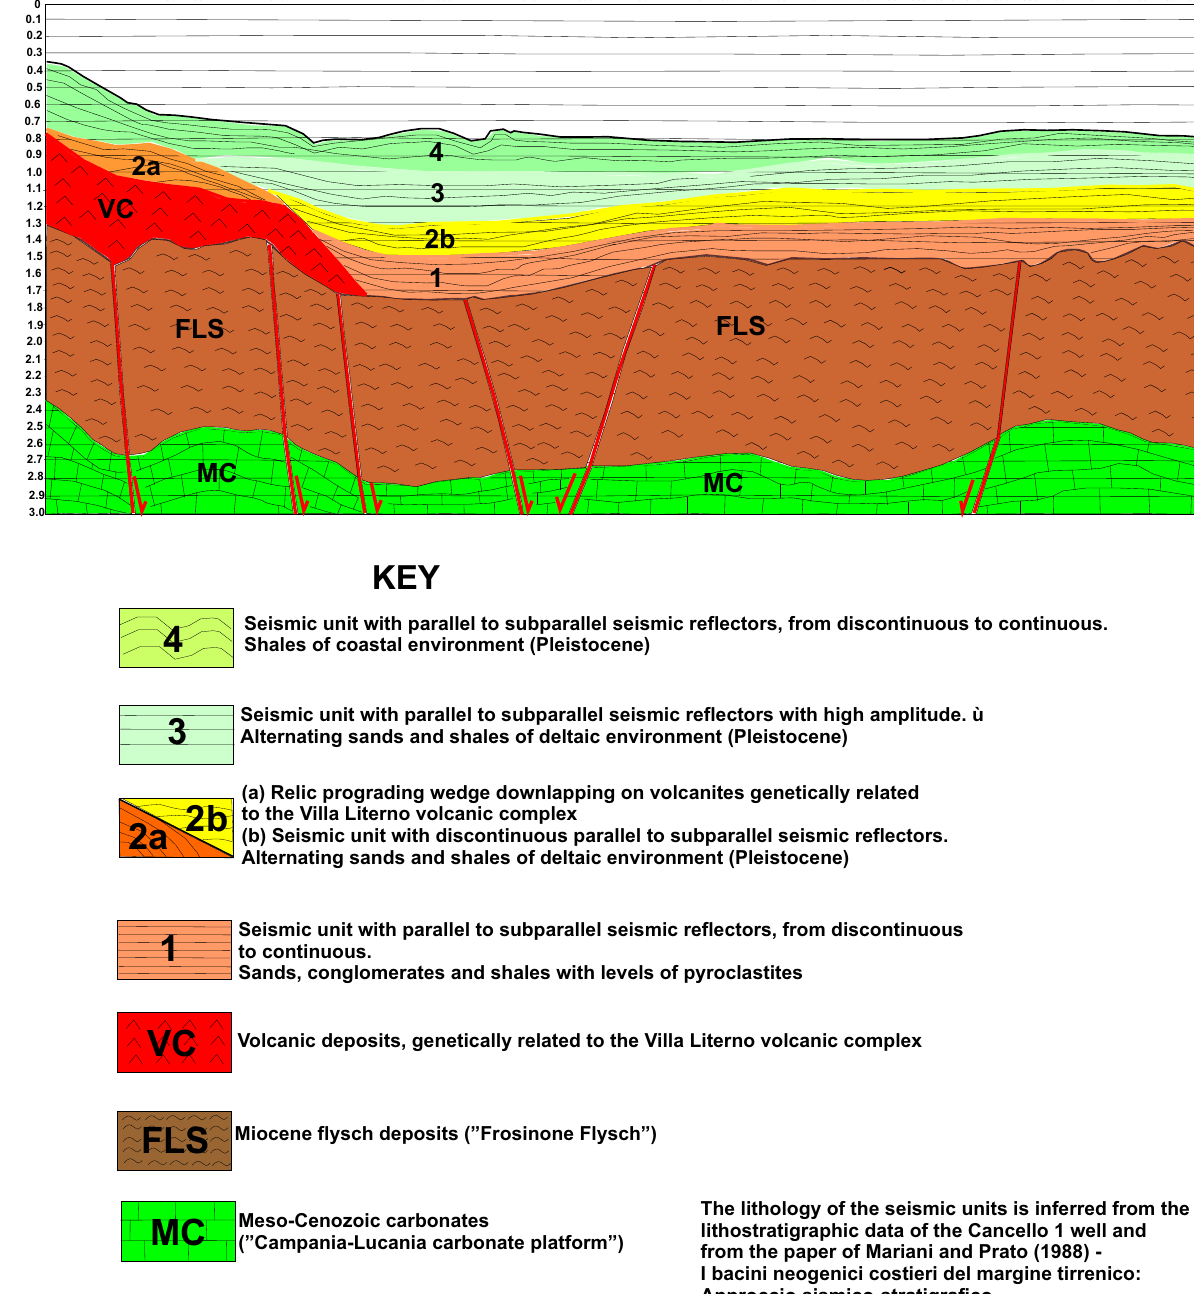
Figure 7. Geological interpretation of the Sister4_2 seismic profile. The lithology was inferred from the lithostratigraphic data of the «Castelvolturno 2» and «Villa Literno 2» boreholes, and defined by additional seismo-stratigraphic data [Mariani and Prato